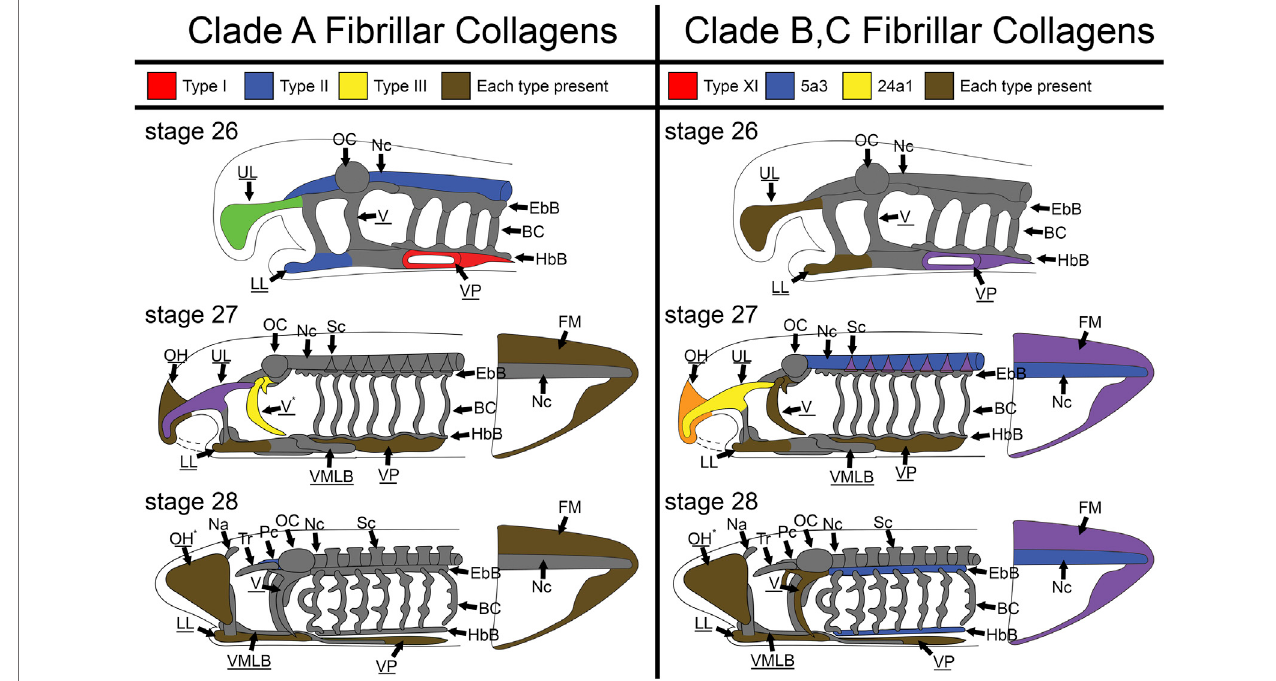
FIGURE 12 | Skeletal heterogeneity of fi brillar collagens in larval lamprey during early development. For stage T26, only the head skeleton is shown, whereas both head and fi n skeleton are shown for T27 and T28. Colors indicate speci fi c subfamilies for each Clade. Minor components of the skeleton for each clade ( colA7 and col5a1 α for Clade A and Clade B respectively) are indicated by an asterisk near the tissue where they are expressed instead of a color. Non-primary colors signify a combinationofcollagensubfamilies,andgrayindicatesno fi brillarcollagens.Underlinekeywordsindicateskeletalpopulationswhichareconsideredmucocartilage. Although fi brillar collagens are largely ubiquitous the oral region and ventral pharynx later in development, they are entirely absent from the branchial cartilages, otic capsule,nasalcapsule,andtrabeculaethroughoutthestagesobserved,andarealsoparticularlylackinginsimilarcartilagesliketheparachordals,epibranchialbars,and hypobranchial bars. Fibrillar collagens are also heterogeneous throughout the posterior mucocartilage. Keywords: BC: branchial cartilages; EbB: epibranchial bars; FM: fi n mesenchyme; HbBL: hypobranchial bars; LL: lower lip; Na: nasal capsule; Nc: notochord; OC: otic capsule; OH: oral hood; Pc: parachordals; Sc: sclerotome;